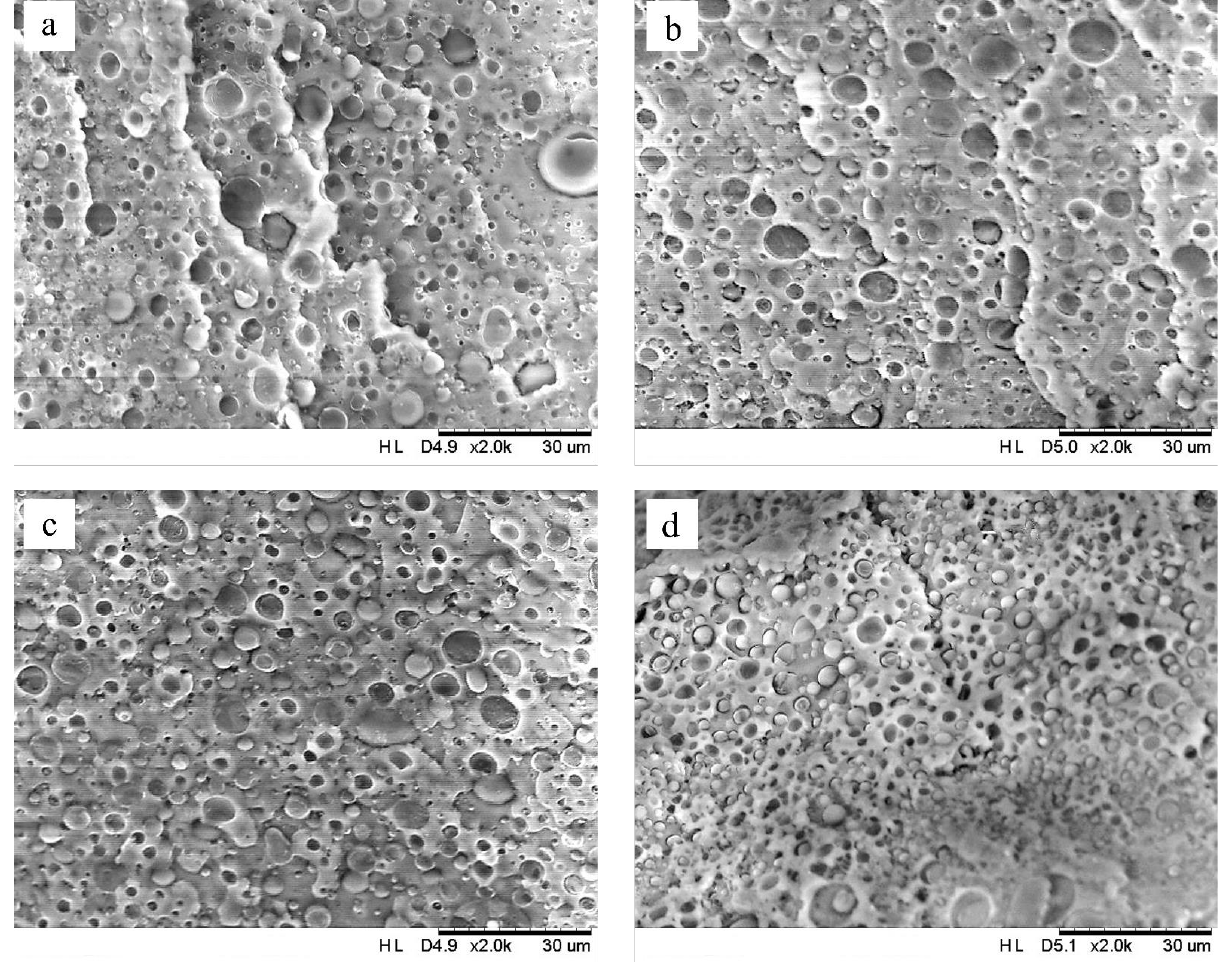
Figure 4. SEM image at 2000× magnification of the fracture surfaces: ( a ) the control PLA/PBSeT blend film; PLA/PBSeT blend films with ( b ) 3 phr g-MAH, ( c ) 6 phr g-MAH, and ( d ) 9 phr g-MAH.